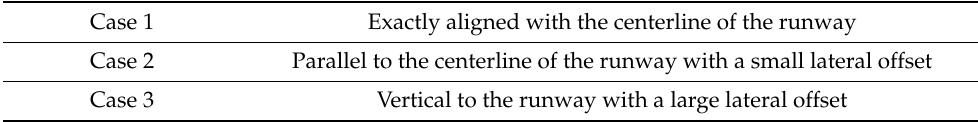
Table 1. The initial conditions of the three different cases. Case 1 Exactly aligned with the centerline of the runway Case 2 Parallel to the centerline of the runway with a small lateral offset Case 3 Vertical to the runway with a large lateral